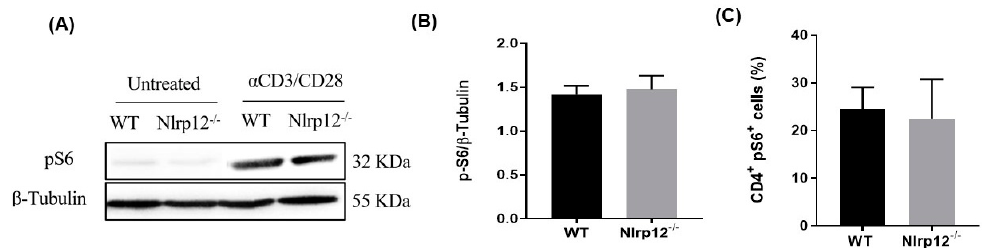
WT and Nlrp12 − / − CD4 + T cells activated with anti-CD3/CD28 for 24 h, as quantified by Western blot, n = 3; ( C ) Phospho-flow analysis of pS6 in CD4 + T cells activated with anti-CD3/CD28 for 24 h, n = for 24 h, n = 3.